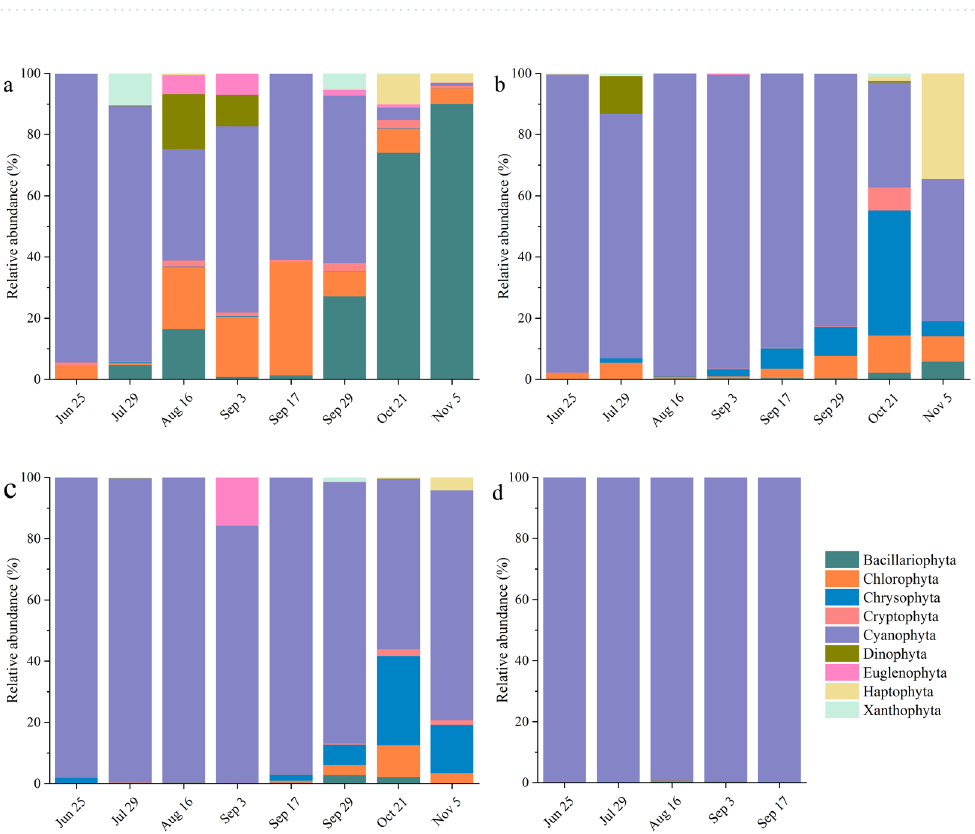
Figure 4. Temporal variation in the relative abundance of phytoplankton at the phylum level in aquaculture water samples ( a ), and hepatopancreases from M. mercenaria ( b ), M. meretrix ( c ), and R. philippinarum ( d ) revealed by high-throughput